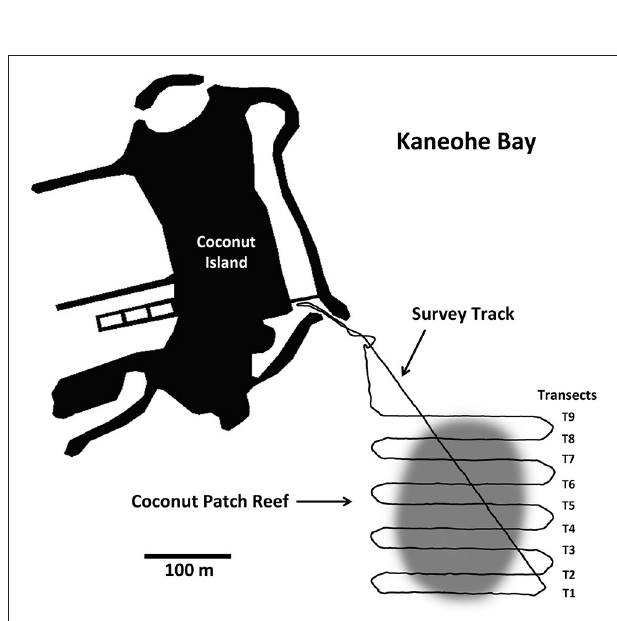
FIGURE 3 | The ASV survey route (black line) on 12 February 2017, included nine East-West transects over the coconut patch reef labeled T1 through T9 from South to